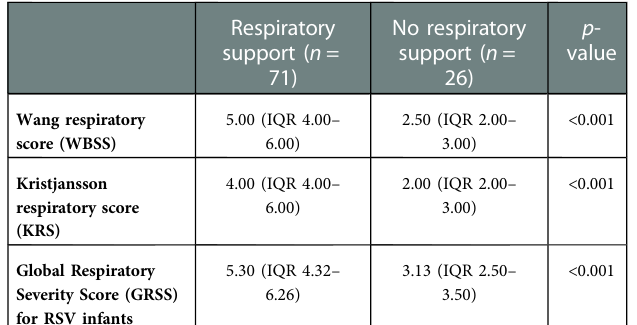
TABLE 4 Differences in bronchiolitis scores (WBSS, KRS, GRSS) between infants who needed respiratory support (HFNC, nCPAP or mechanical ventilation) or not.